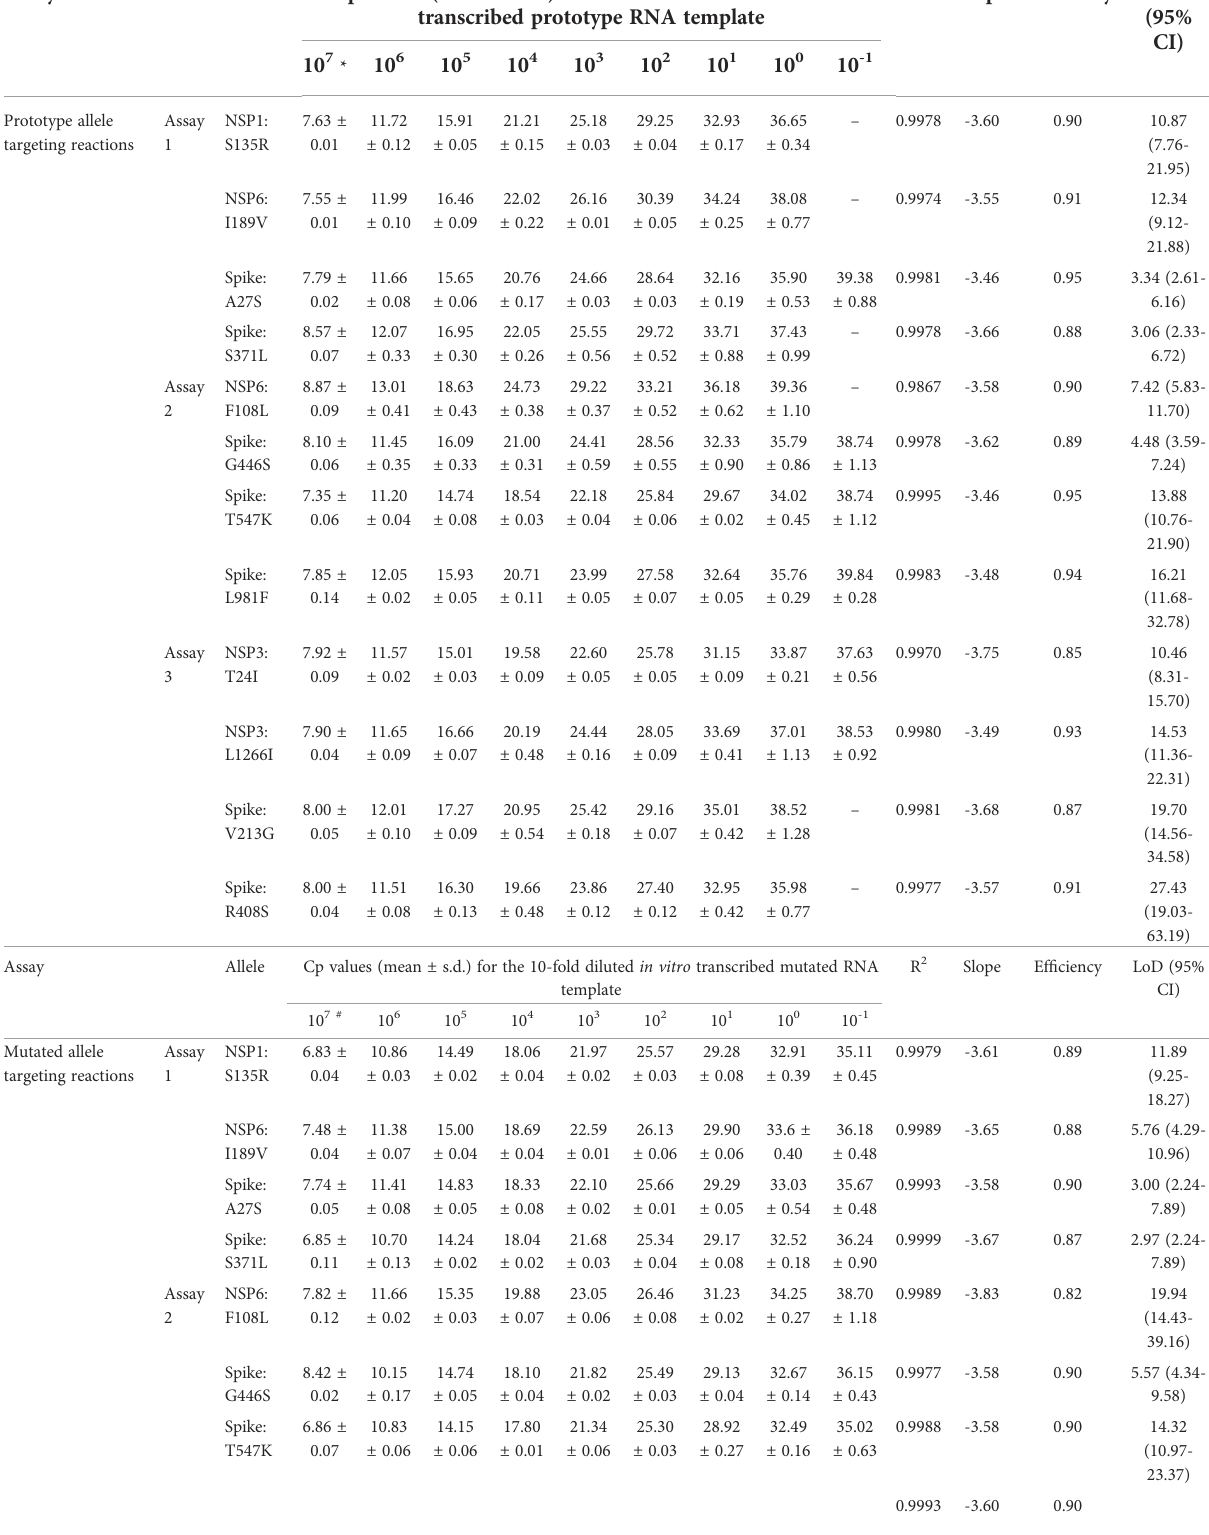
TABLE 2 Linear detection ranges and ampli fi cation ef fi ciencies of the developed multiplex allele-speci fi c qRT-PCR assays. Assay